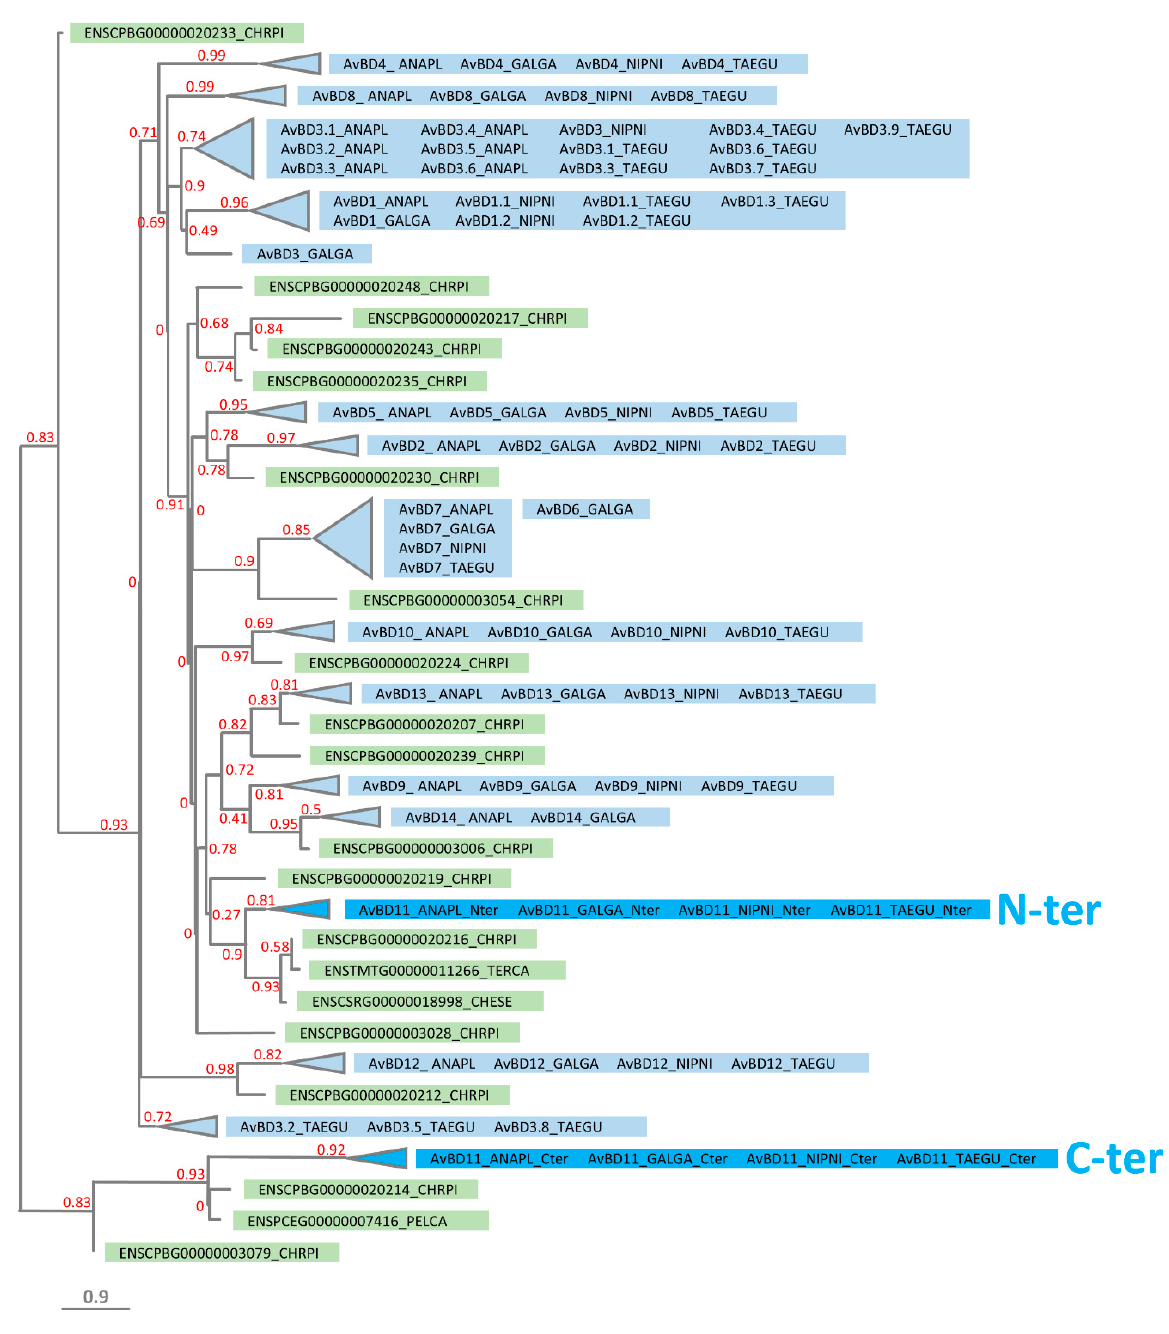
Figure 9. Phylogenetic relationships of the N-terminal (N-ter) and C-terminal (C-ter) domains of AvBD11 with monodomain AvBDs and turtle β -defensins. The phylogenetic tree was constructed using the maximum-likelihood-based program PhyML from MAFFT-based alignments adjusted to the length of N-ter and C-ter AvBD11. Branch support values are indicated in red. Bird and turtle β -defensins are highlighted in blue and in green, respectively. Bird species acronyms: ANAPL, Anas platyrhynchos (duck); GALGA, Gallus gallus (chicken); NIPNI, Nipponia nippon (crested ibis); and TAEGU, Taeniopygia guttata (zebra finch). Turtle species acronyms: CHRPI, Chrysemys picta bellii (western painted turtle); TERCA, Terrapene carolina triunguis (three-toed box turtle); CHESE, Chelydra serpentina (common snapping turtle); and PELCA, Pelusios castaneus (west african mud turtle).